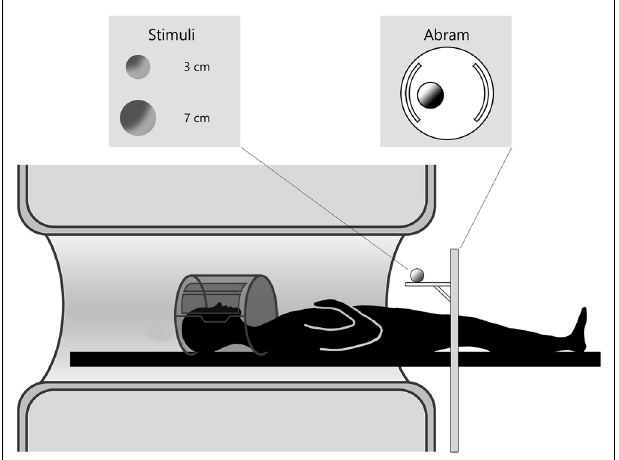
FIGURE 1 | Experimental setup of data acquisition. The participant is laying in the MR scanner and the motorized platform ABRAM is presenting stimuli following a sequence administered by a PC in the control room.The position of the rotating platform plus a pillow slightly tilting the head allow for direct viewing of the